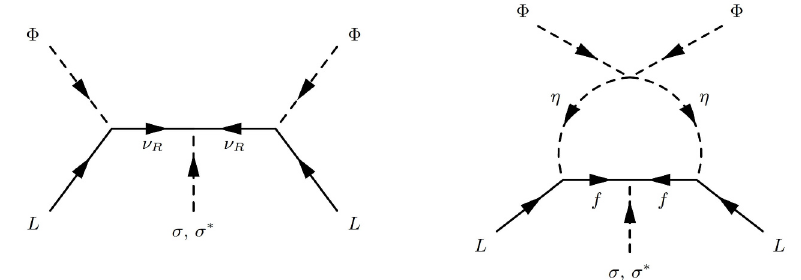
Figure 2 . Neutrino mass diagrams in the minimal scotogenic seesaw model with LCPV induced by the couplings with a complex scalar singlet σ and its conjugate σ ∗